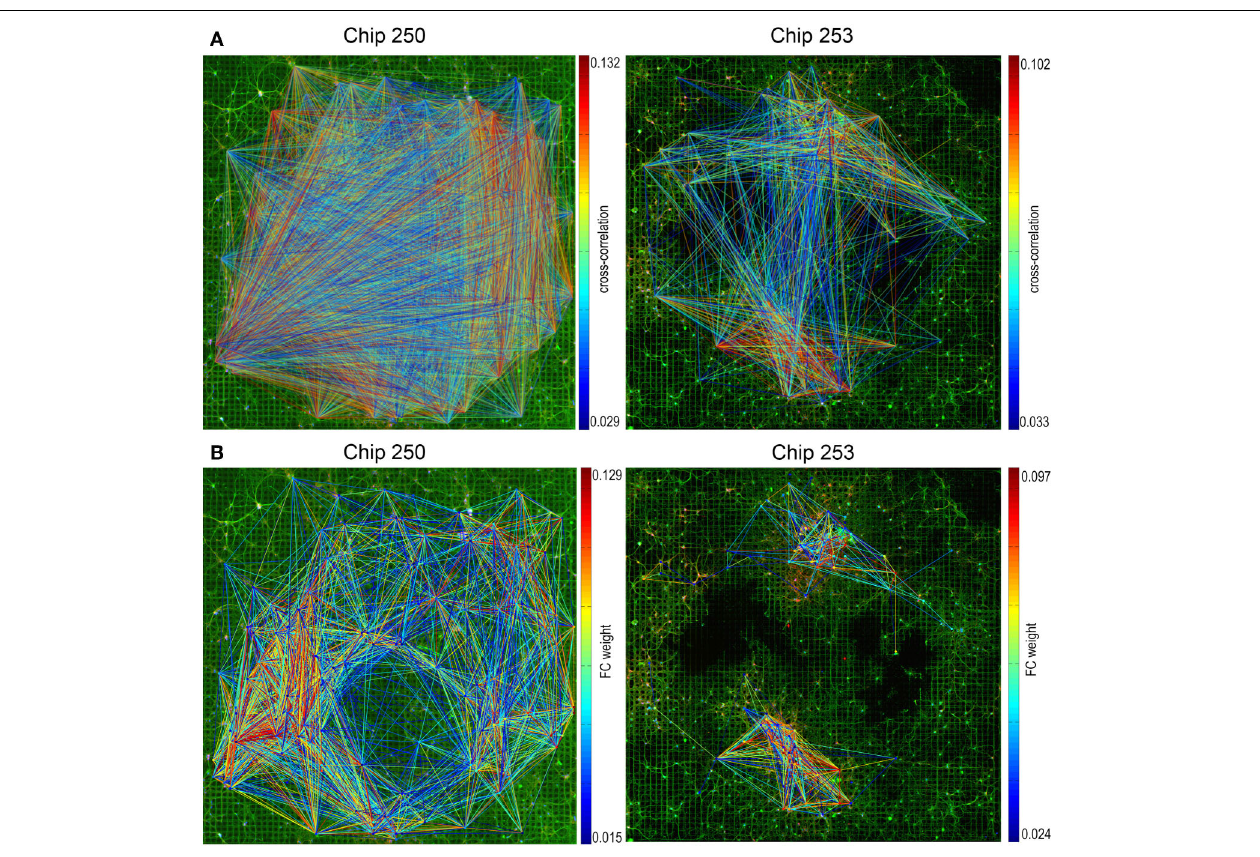
FIGURE 6 | Functional connectivity graphs. (A) Functional connectivity graphs estimated computing cross-correlations on the pairwise electrophysiological signals and applying spatio-temporal filters and a significance threshold based on dithering. Functional links are color-coded